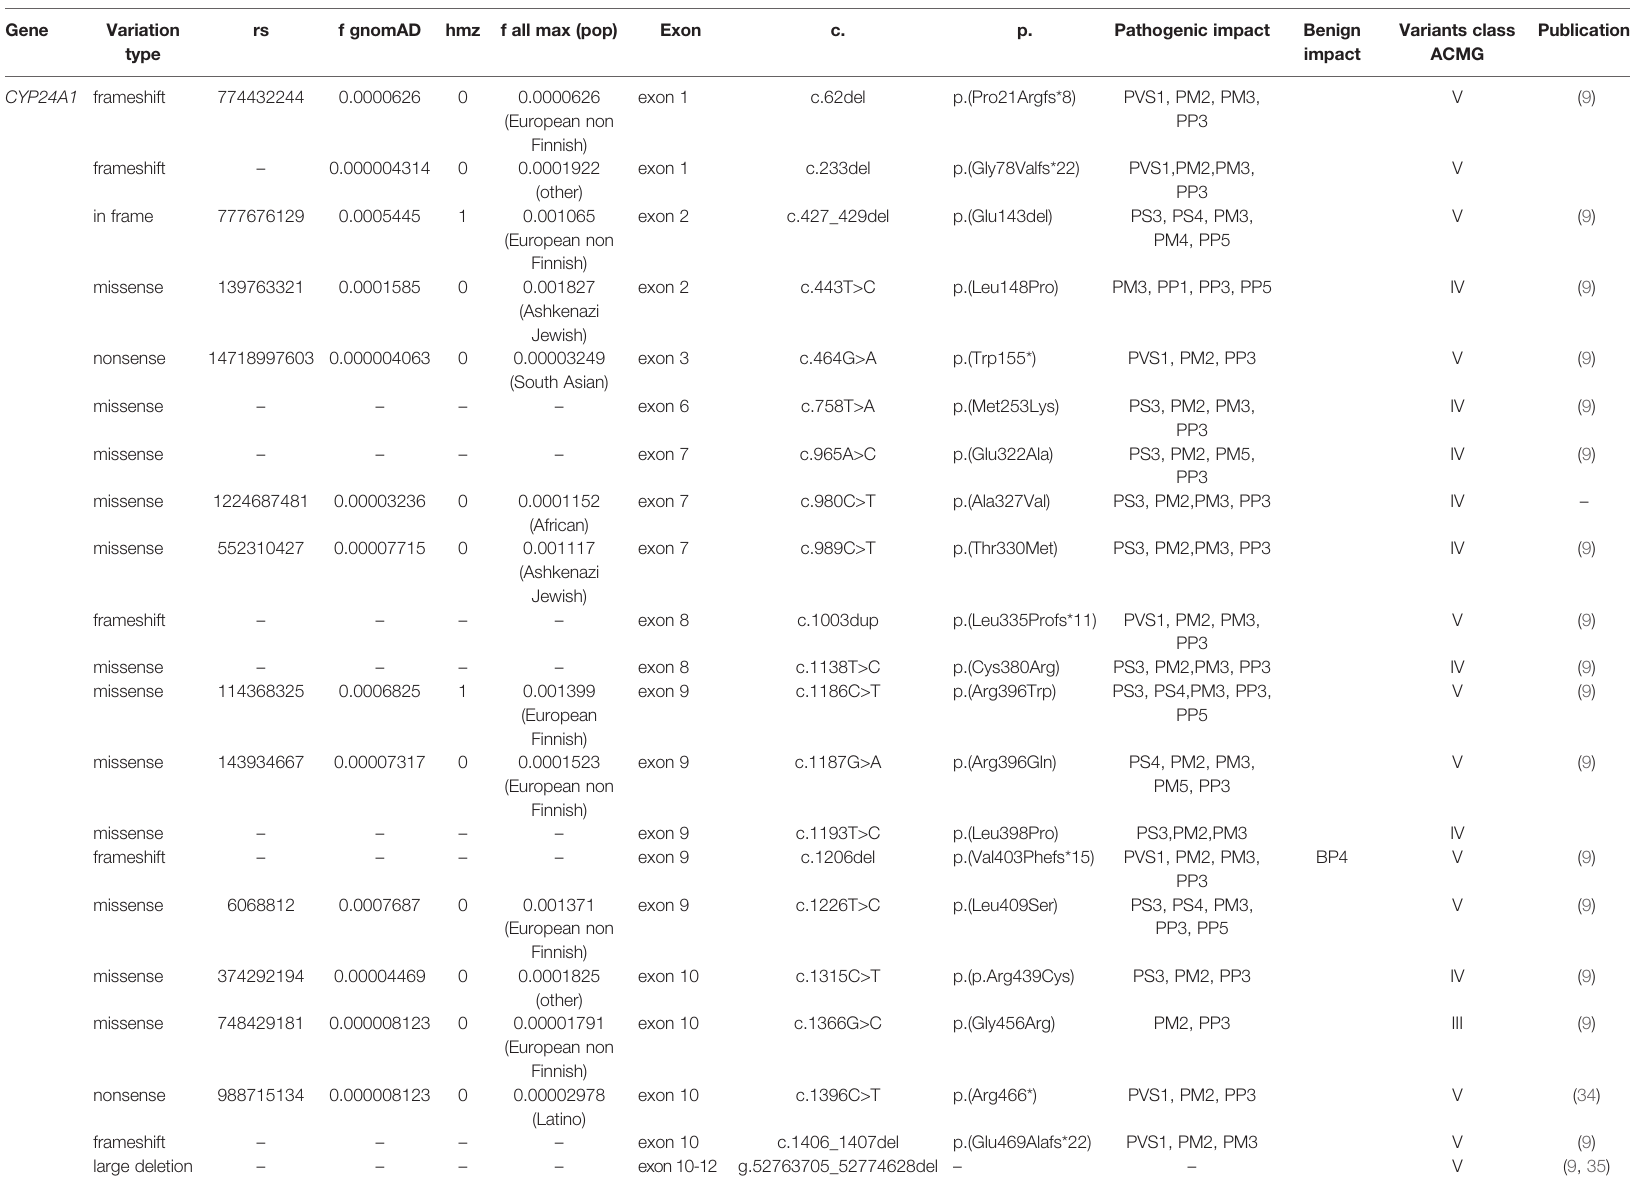
TABLE 1 | Description of genetic variations which were identi fi ed in CYP24A1 , SLC34A1 and SLC34A3